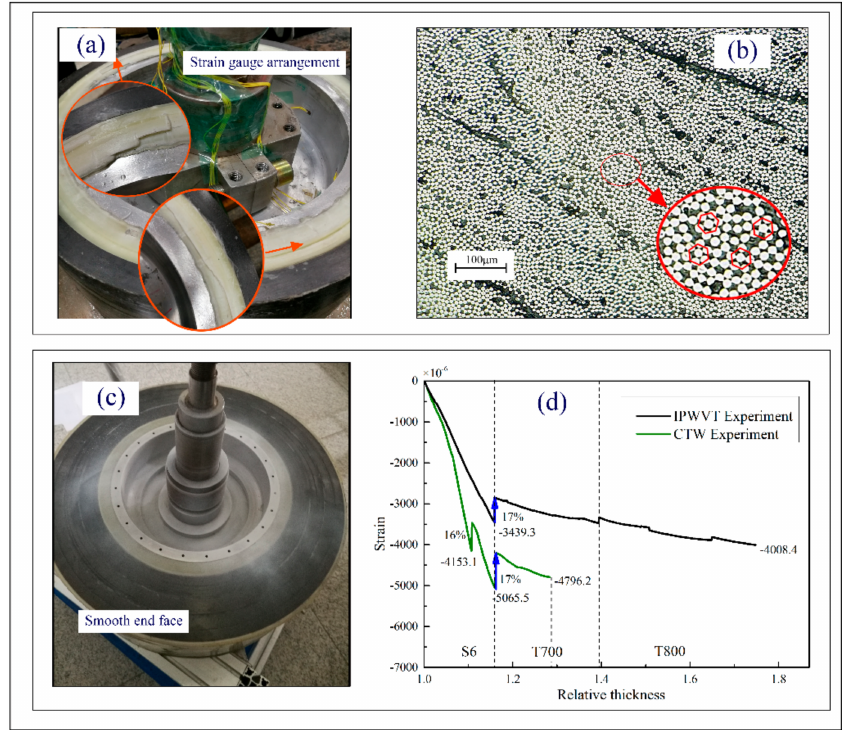
Figure 5. ( a ) Morphology of CTW and strain gauge arrangement; ( b ) metallographic picture; ( c ) mor- phology of IPWVT; and ( d ) results of online strain with respect to relative